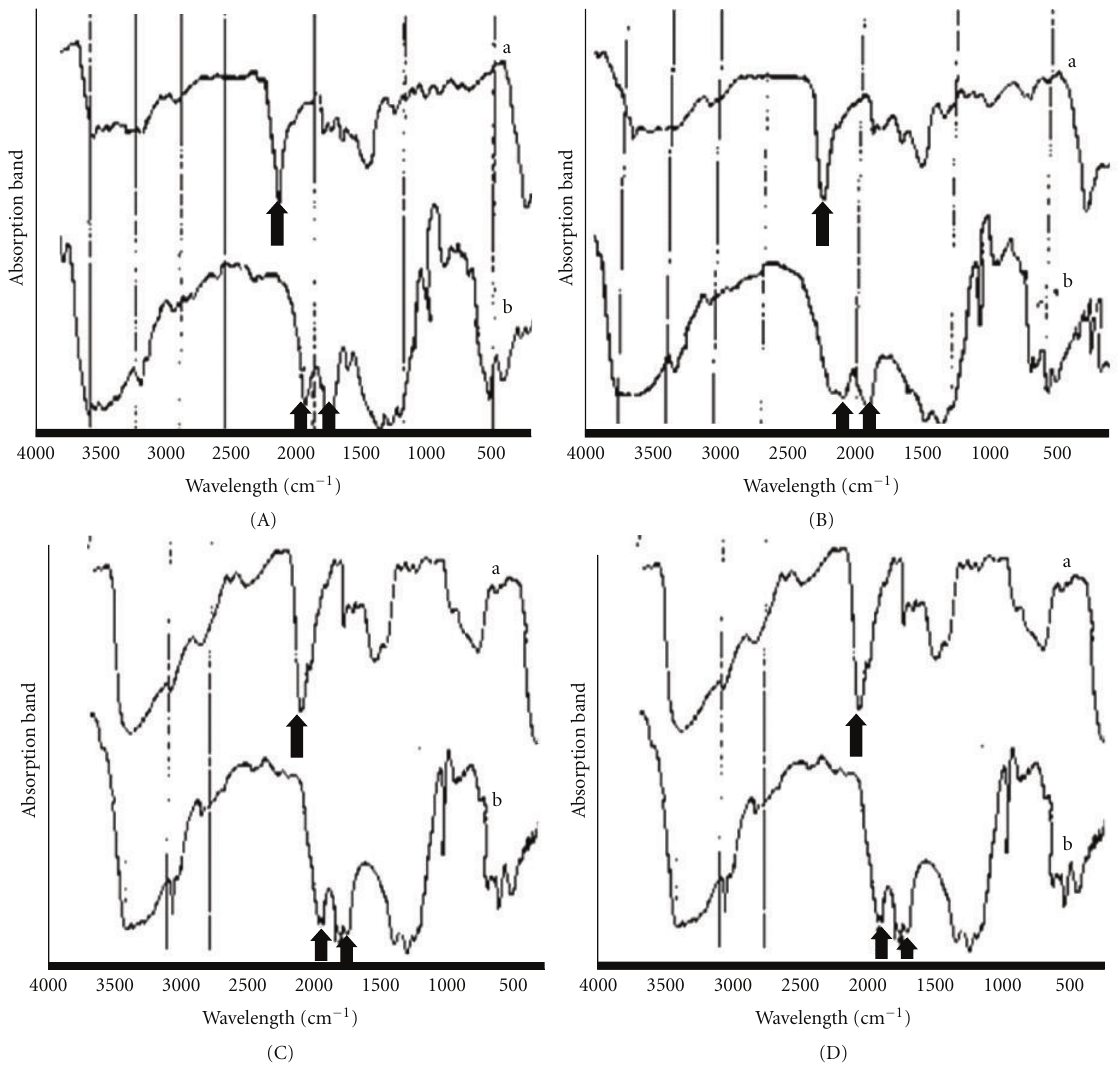
Figure 3: (A) Zinc polycarboxylate cement; (B) Type I; (C) Type II; (D) Type III. For all cements tested, IR spectra of polymeric acids (modified polyacrylic acid, modified polyalkenoic acid, 35% w/w aqueous solution of PMVE-Ma (a) showed the absorption bands of car- boxylic group (C = O) between 1635 to 1640 cm − 1 cm (arrows). IR spectra of set cements (b) showed the absorption bands between 1558 and 1401 cm − 1 indicating the formation of carboxylic salts